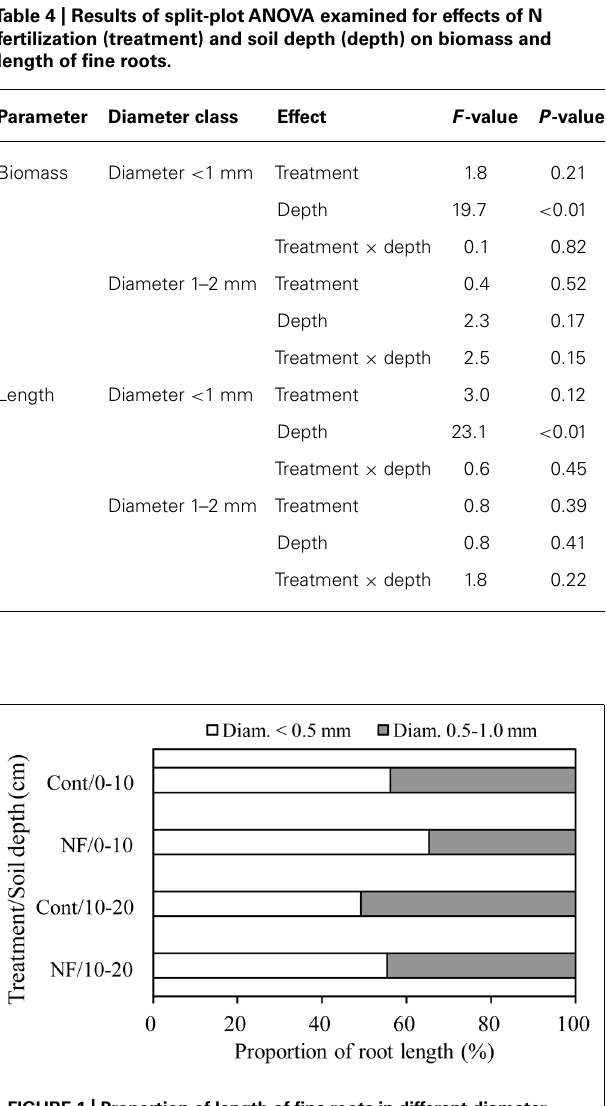
Data shown are means ± SE (N = 5).